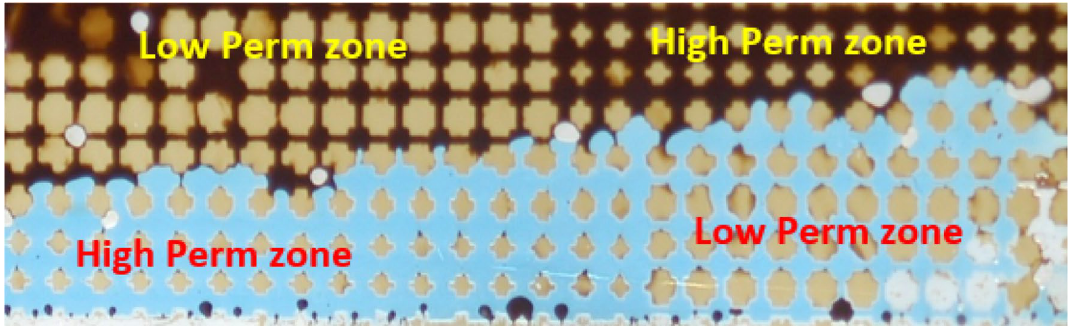
Fig. 11 Polymer front movement in quadratic flow pattern, polymer is injected from the left (brown color is oil, light yellow color is grain and blue color is polymer solution)